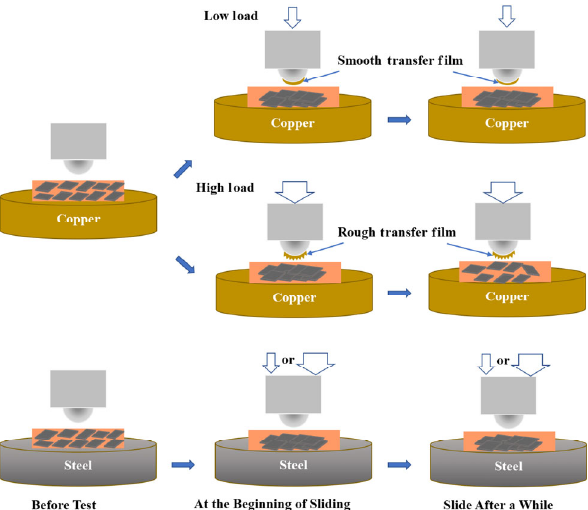
Fig. 11 The evolution of the graphene boundary tribofilm during